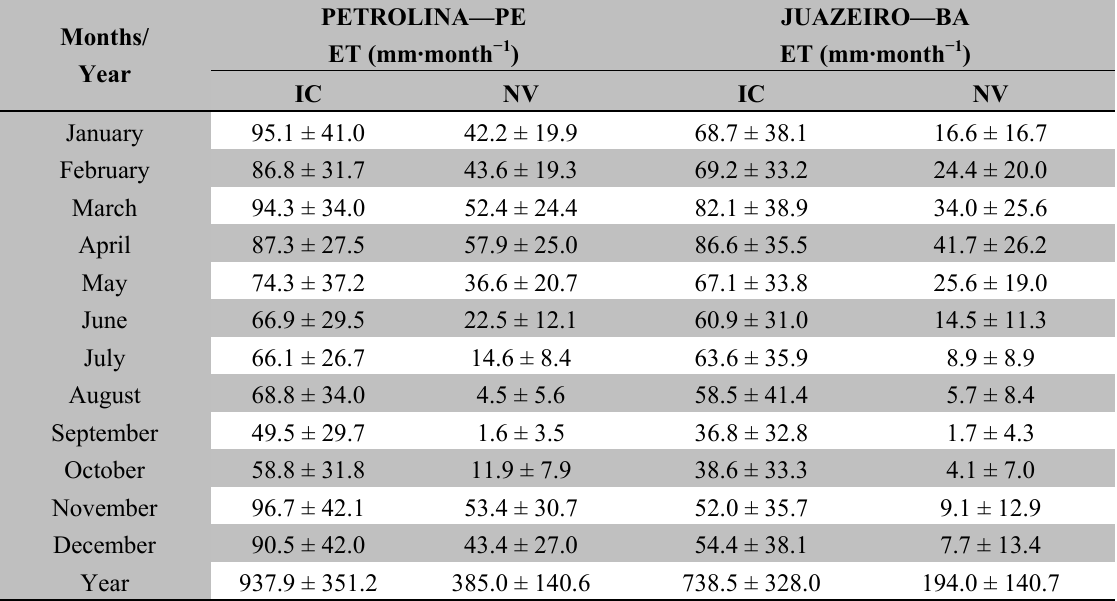
Table 1. Monthly average values and standard deviations (SD) of actual evapotranspiration (ET) from irrigated crops (IC) and natural vegetation (NV) in Petrolina and Juazeiro municipalities, respectively Pernambuco (PE) and Bahia (BA) states, Brazil, during the year of